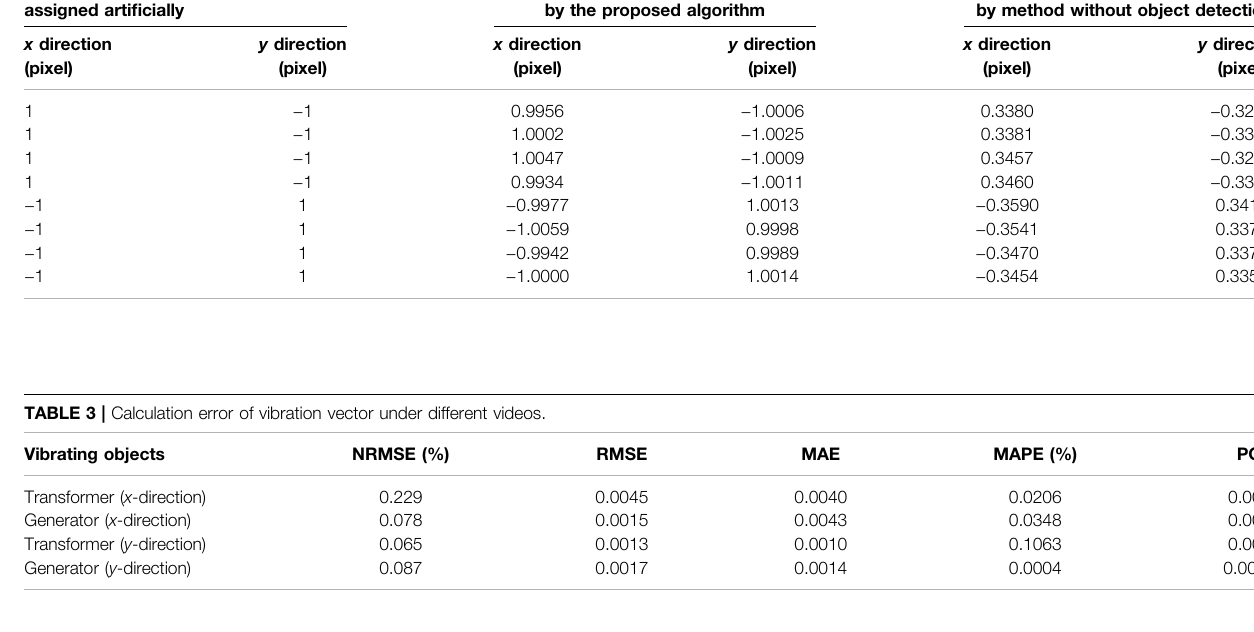
TABLE 2 | Comparison between the generator vibration vectors calculated by the proposed algorithm and the vibration vectors which are assigned arti fi cially. Generator vibration vectors which are assigned arti fi